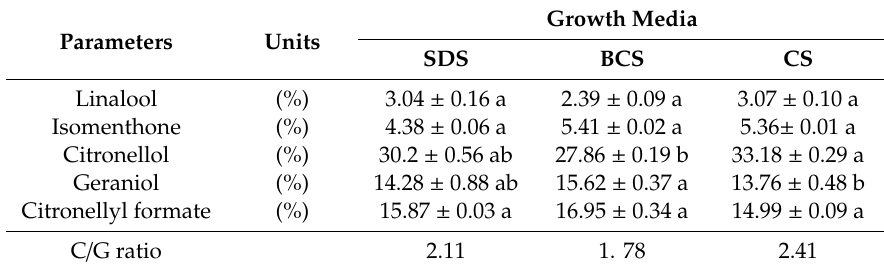
Table 4. The e ff ects of growth media on the main chemical components of essential oil in P. graveolens cultivation. All values are means of three replicates ± standard deviation. SDS, solid digestate growth media; BCS, biochar growth media; CS, control growth